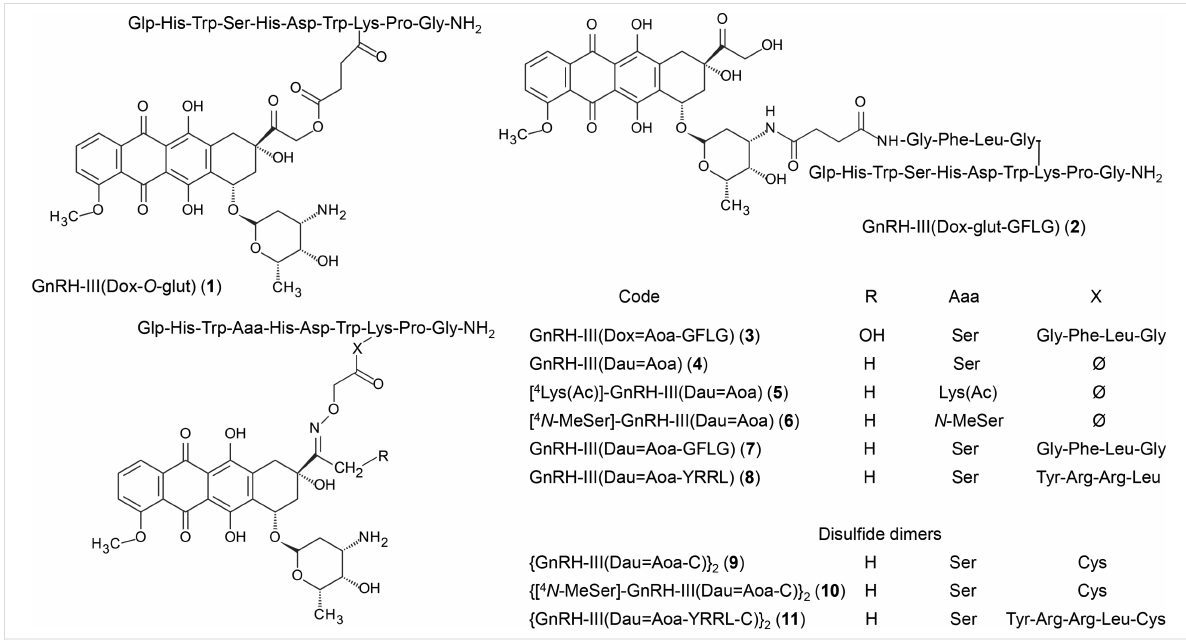
Figure 1: Chemical structures of the GnRH-drug conjugates synthesized and investigated in the present work. Abbreviations: Aoa: aminooxyacetyl; Dox: doxorubicin; Dau: daunorubicin; Mtx: methotrexate; Glp: pyroglutamic acid; gult: glutaric